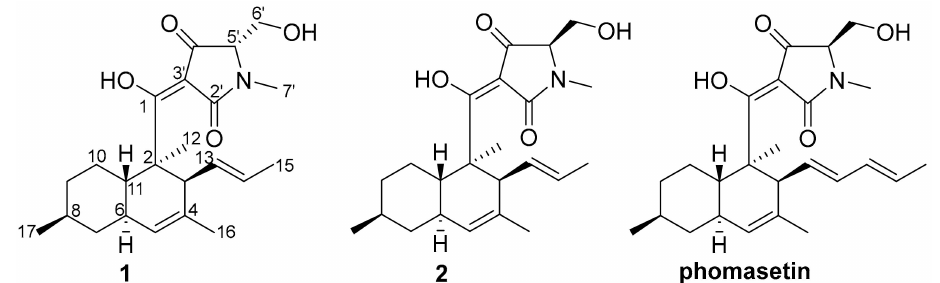
Figure 1. Structures of the isolated compounds 1 and 2 , and